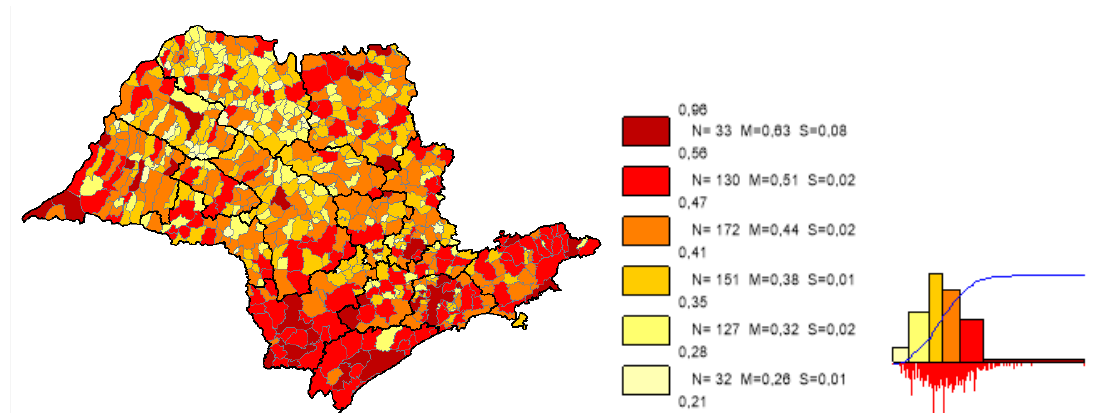
Figure 10. Distribution of inequity regarding overall income distribution (Theil index), in the municipalities of the state of SP. Note: Choropleth maps, consisting of six divisions, using the following limits—minimum value; 5th percentile; 25th, 50th and 75th percentiles; 95th percentile and maximum value. For each interval, the number (N) of municipalities, their mean (M) and standard deviation (S) are described. The histograms contain bars proportional to the number of localities in each division ( Philcarto images).